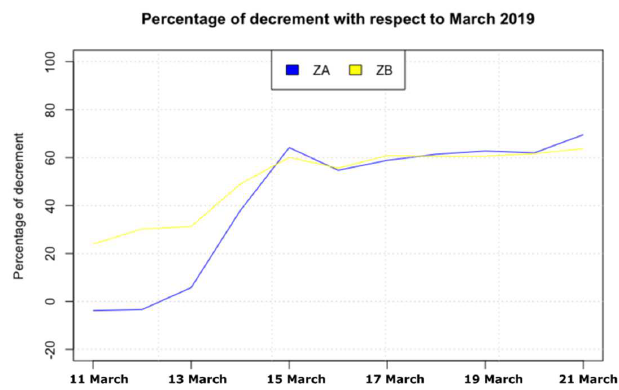
Figure 8. Time evolution of the percentage drop for the number of devices in study areas during the week that includes the start date of the lockdown in Spain (14 March 2020), compared to 2019.